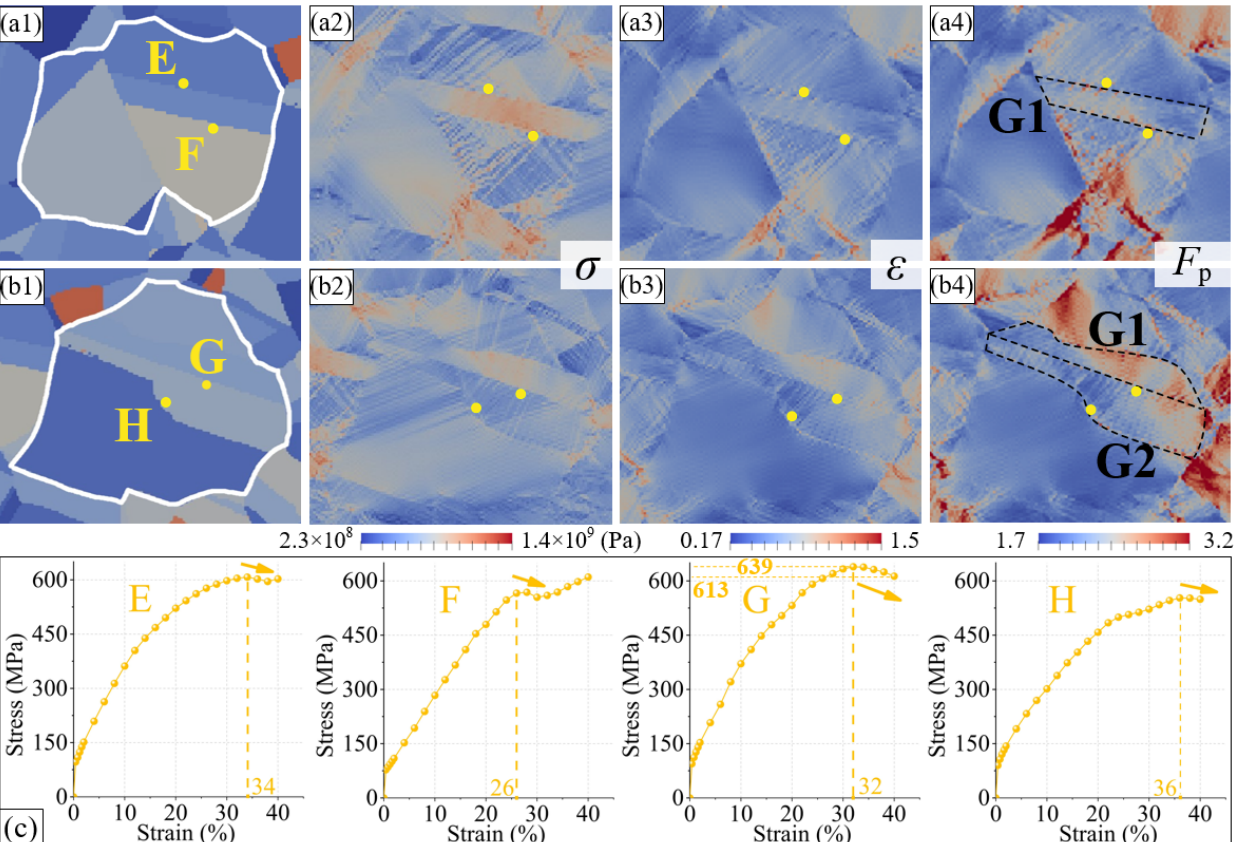
Figure 9. ( a1 ) The position of points near Σ 3 boundaries at initial simulation state in grain group GG Ⅰ . ( a2 – a4 ) The distribution of stress, strain, and plastic deformation gradient at final simulation state in grain group GG Ⅰ . ( b1 ) The position of points near Σ 3 boundaries at initial simulation state in grain group GG Ⅱ . ( b2 – b4 ) The distribution of stress, strain, and plastic deformation gradient at final simulation state in grain group GG Ⅱ . ( c ) The stress variation of points E–H.